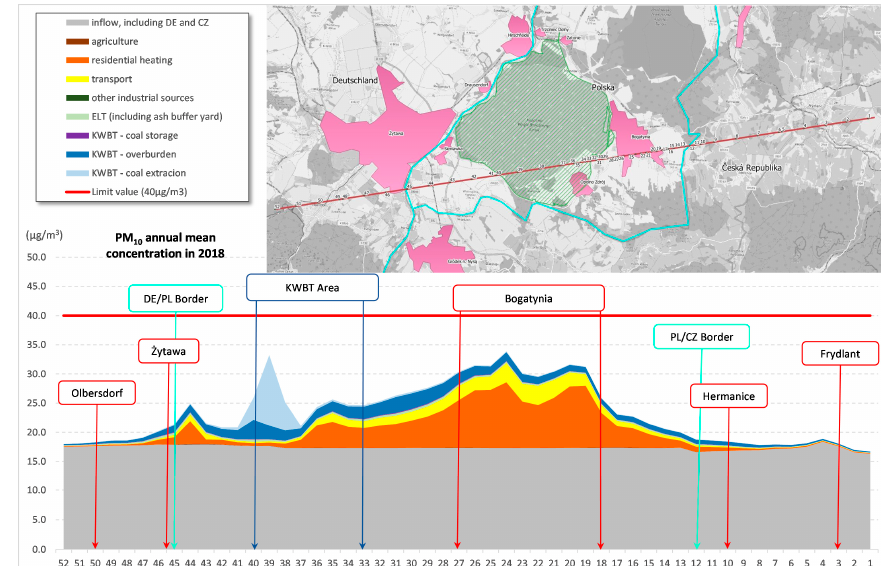
Figure 19. Profile of annual mean concentrations of PM 10 between Dzia ł oszyn and Hrádek nad Nisou, considering the shares of individual source groups in 2018 (source: own study).